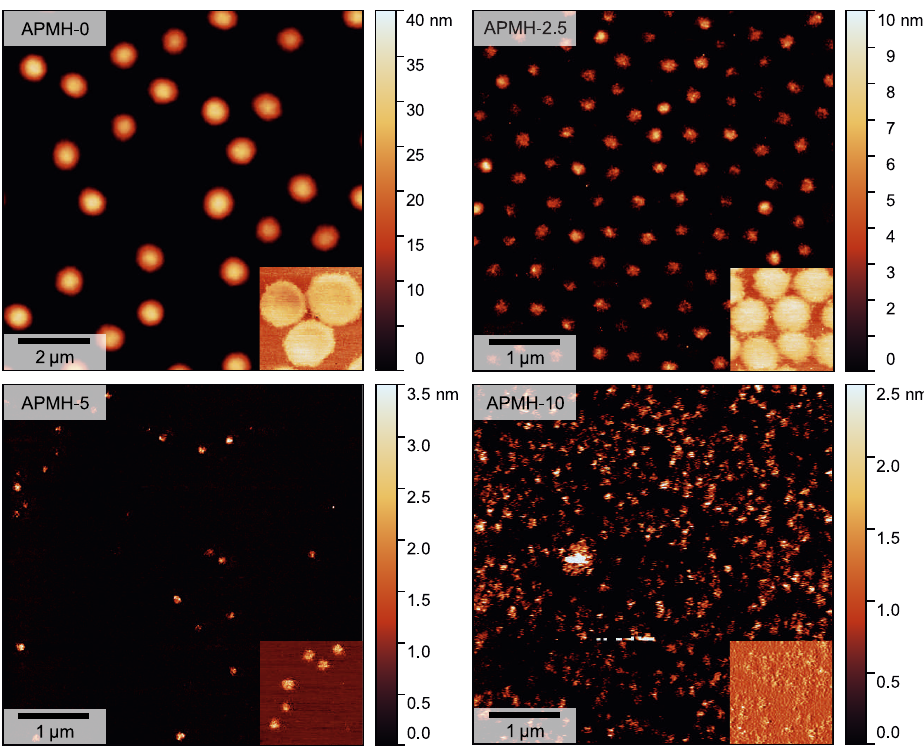
Figure 3. AFM images (topography) of the obtained poly(NIPAM- co -APMH) microgels. The insets show representative cutouts of the respective phase-image (same lateral scale). The samples were measured in the dried state at room temperature.